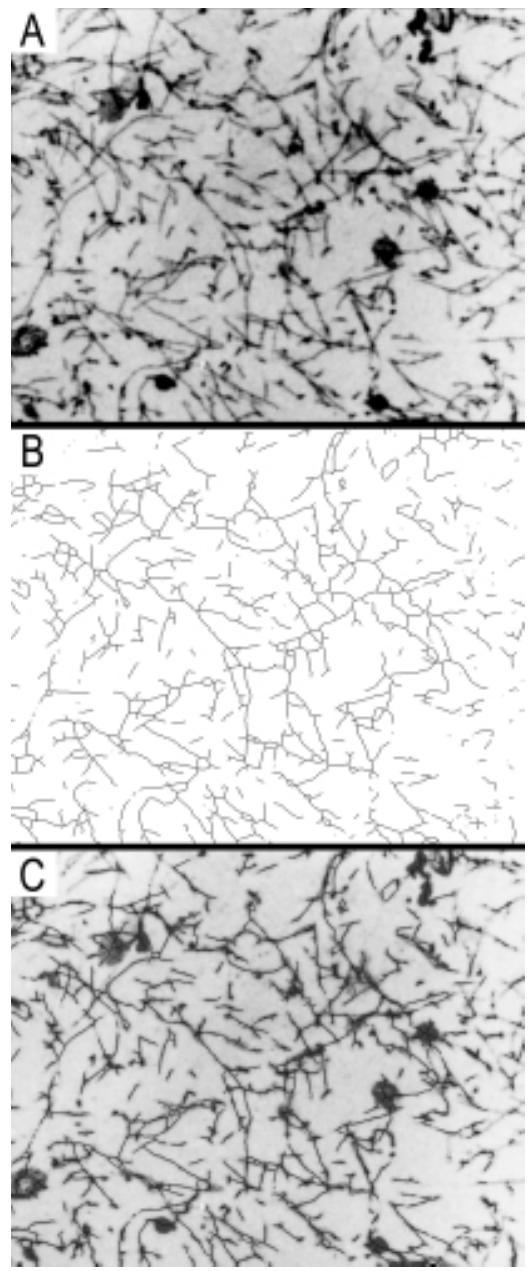
Fig. 4 – A= Transmission electron microscopy of cytoskeletal filamentsfromthemainelectricorganof E.electricus ;B=Digital processing of the imageA, using an erosion morphing procedure (skeletonize) to outline the filaments; C = Superimposition of images A and B. We used the programs NIH Image and Adobe PhotoShop. Picture A was given by Dr. Marlene Benchimol.